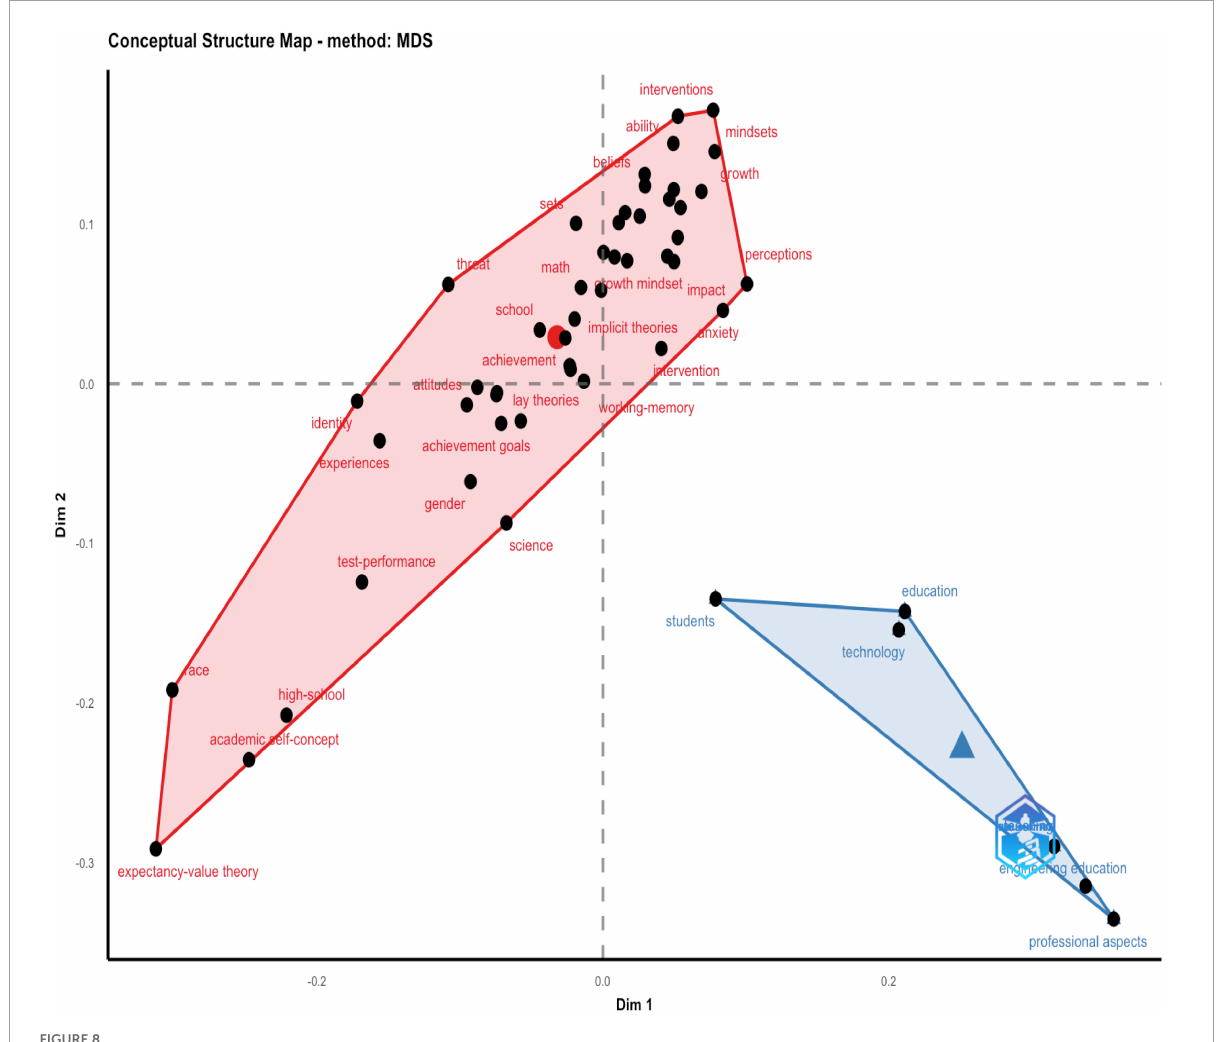
FIGURE8 The conceptual structure of factor